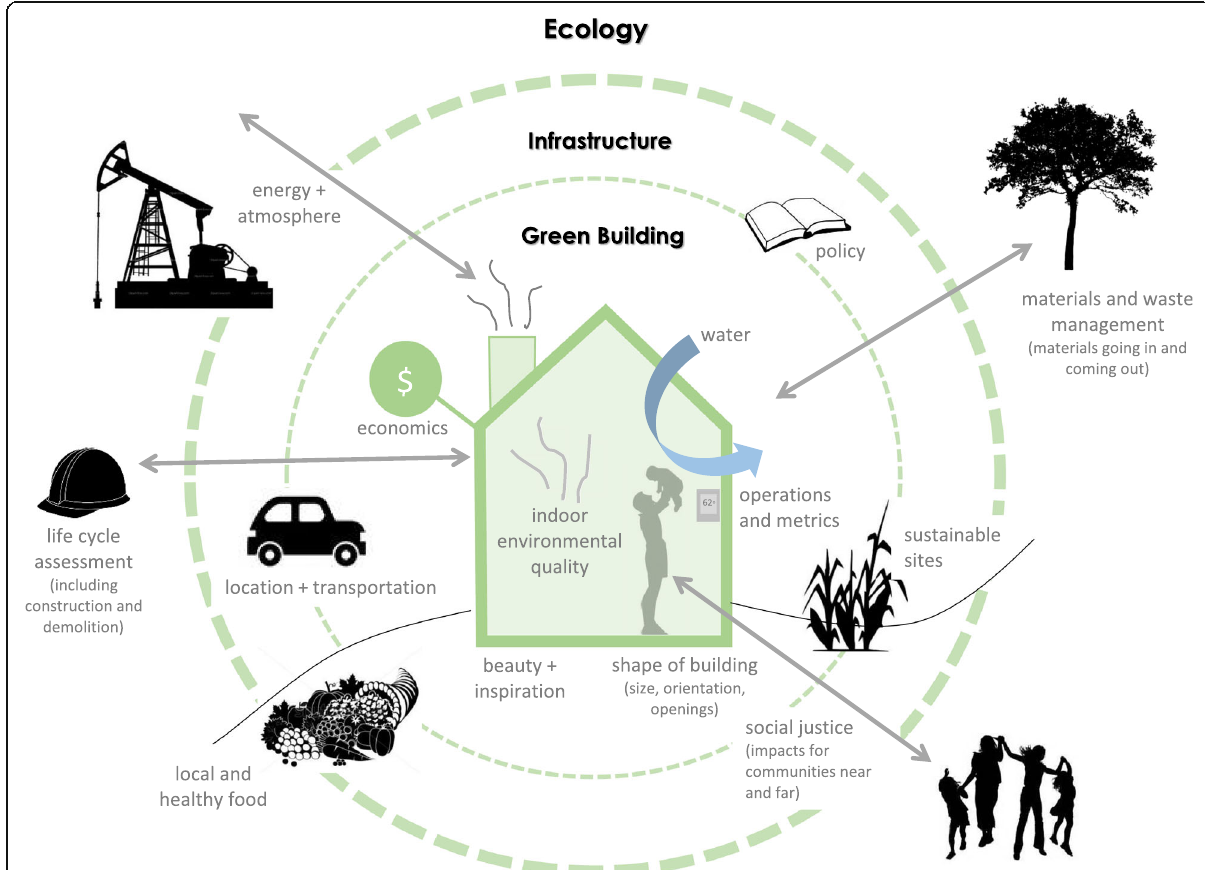
Fig. 1 Factual and conceptual green building knowledge. This diagram shows the many ways that green building themes can be connected to broader social and ecological